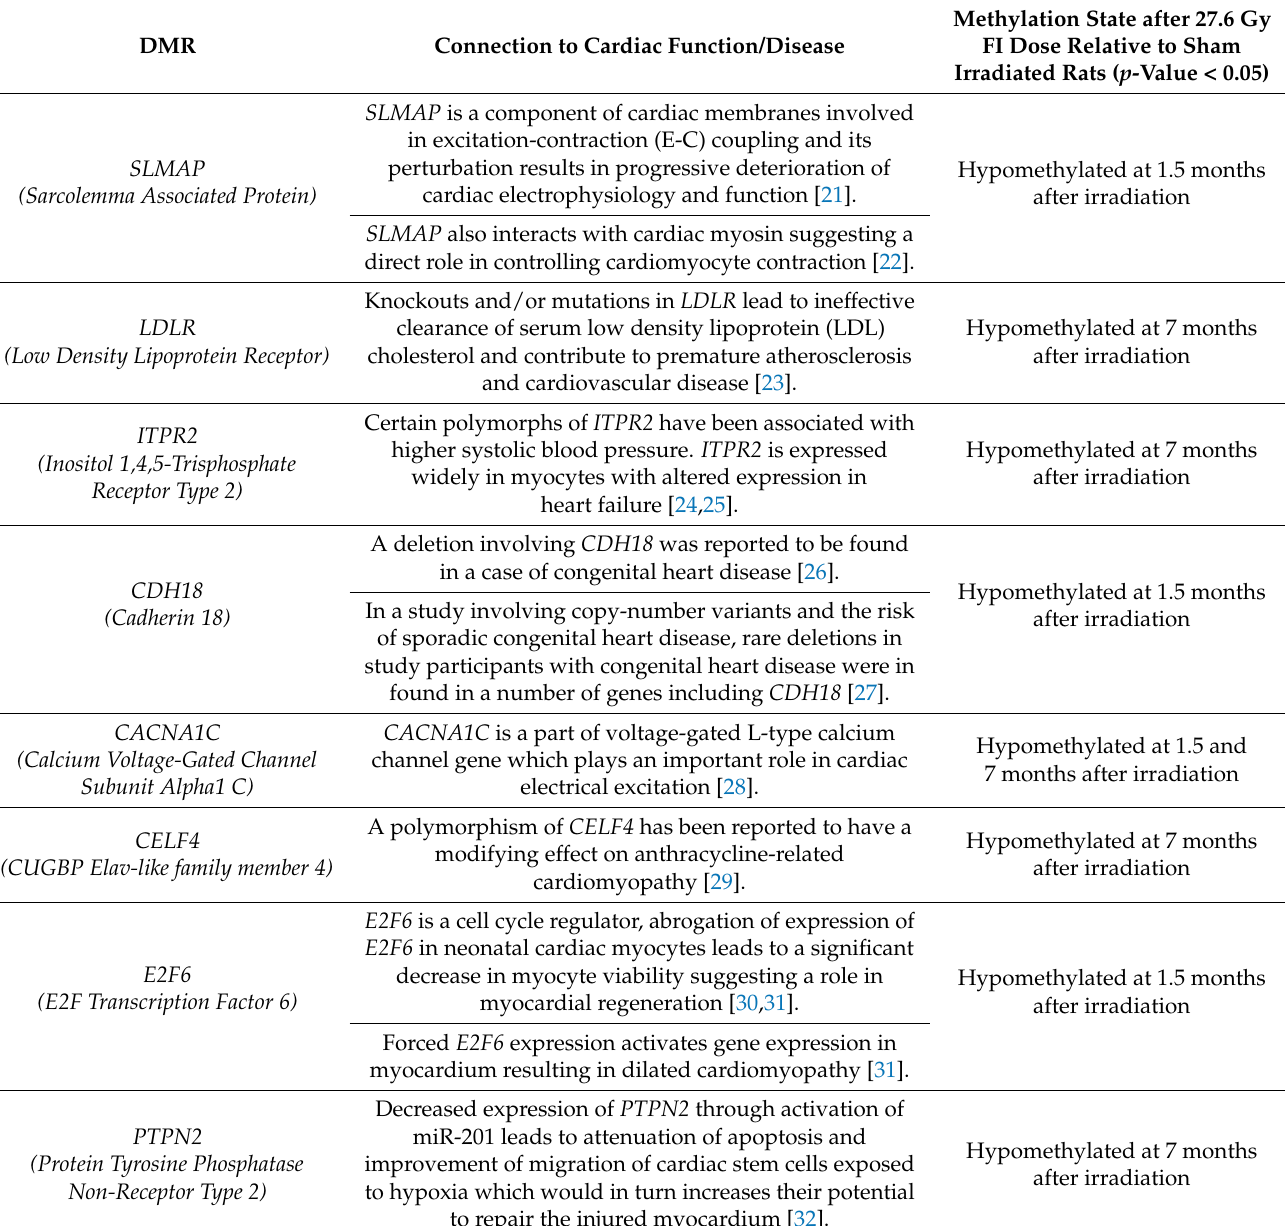
Table 1. DMRs selected for downstream validation, their correlation to cardiovascular func- tion/disease and their altered methylation status after 27.6 Gy FI.